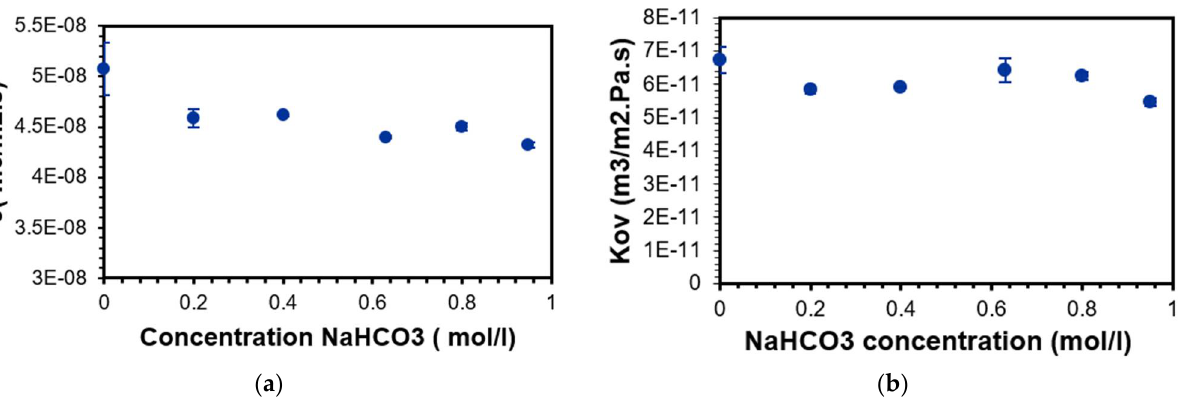
Figure 5. Effect of the concentration of NaHCO 3 in the feed solution on: ( a ) flux and ( b ) K ov . Feed velocity was 0.038 m/s, osmotic velocity was 0.01 m/s, and osmotic and feed solutions were at room temperature.